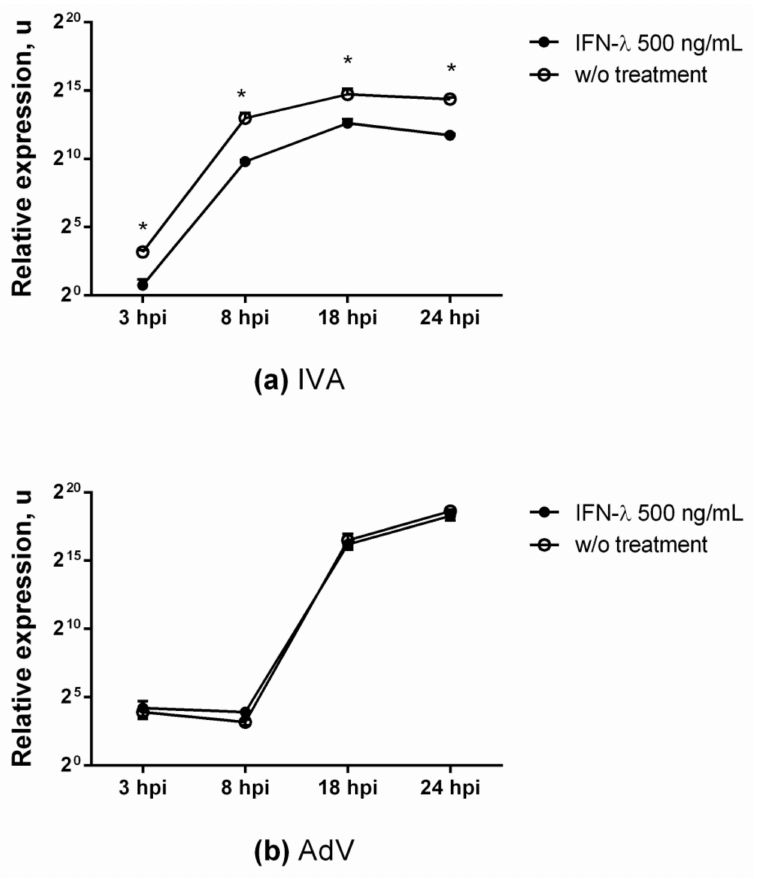
Figure 5. Effect of IFN- λ 1 treatment on replication of the IVA (a) and AdV (b) genomes . Viral RNA yields (normalized to GAPDH) were determined after infection of A549 cells (untreated or IFN- λ 1 treated at 500 ng/mL) with IVA or AdV (both 0.1 MOI). All data are representative of at least three independent experiments. p value significance levels were determined by unpaired nonparametric Mann–Whitney test (U-test). *— p value = 0.0286. Data are shown as mean ±